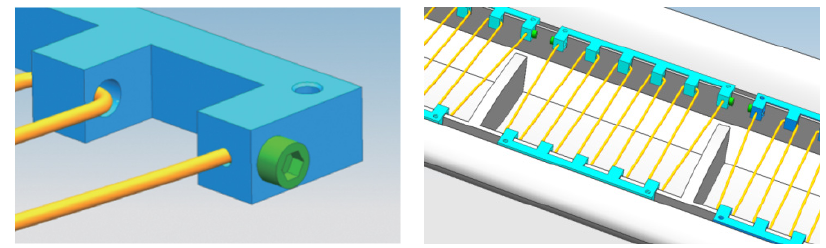
Figure 7. Schematic diagram of the model